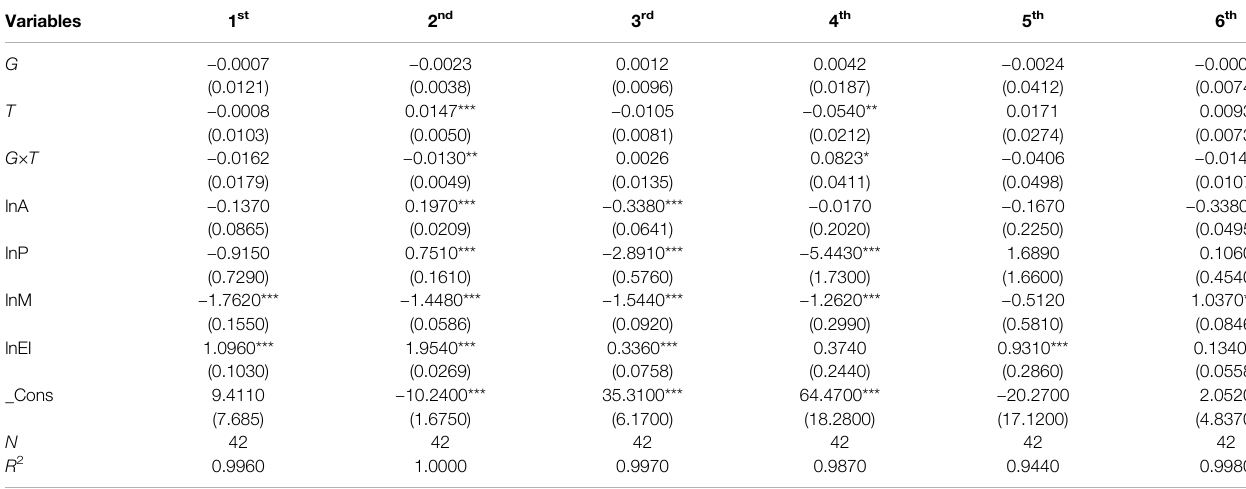
TABLE 5 | The results of the heterogeneity test in China ’ s six sectors.